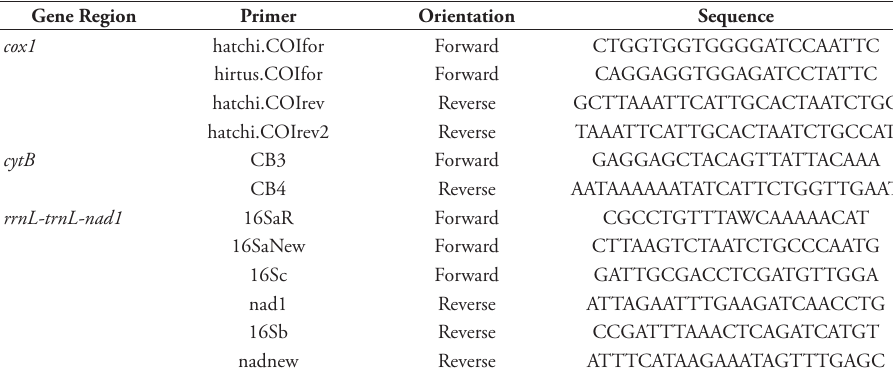
Table 2. Primers used, in 5’ to 3’ orientation. Primers were based on Ribera et al. (2010) but modified based on sequences available from Ptomaphagus hirtus (Friedrich et al. 2011). Gene Region Primer Orientation Sequence cox1 hatchi.COIfor Forward CTGGTGGTGGGGATCCAATTC hirtus.COIfor Forward